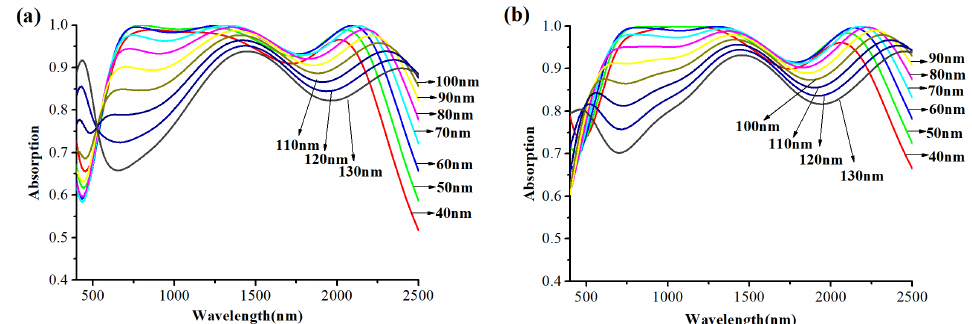
Figure 6. The absorption curves of the absorber with the distance L 2 between tungsten nanosphere layer and MXene layer increasing from 40 to 130 nm: ( a ) the thickness of the MXene layer is 30 nm; ( b ) the thickness of the MXene layer is 400 nm.